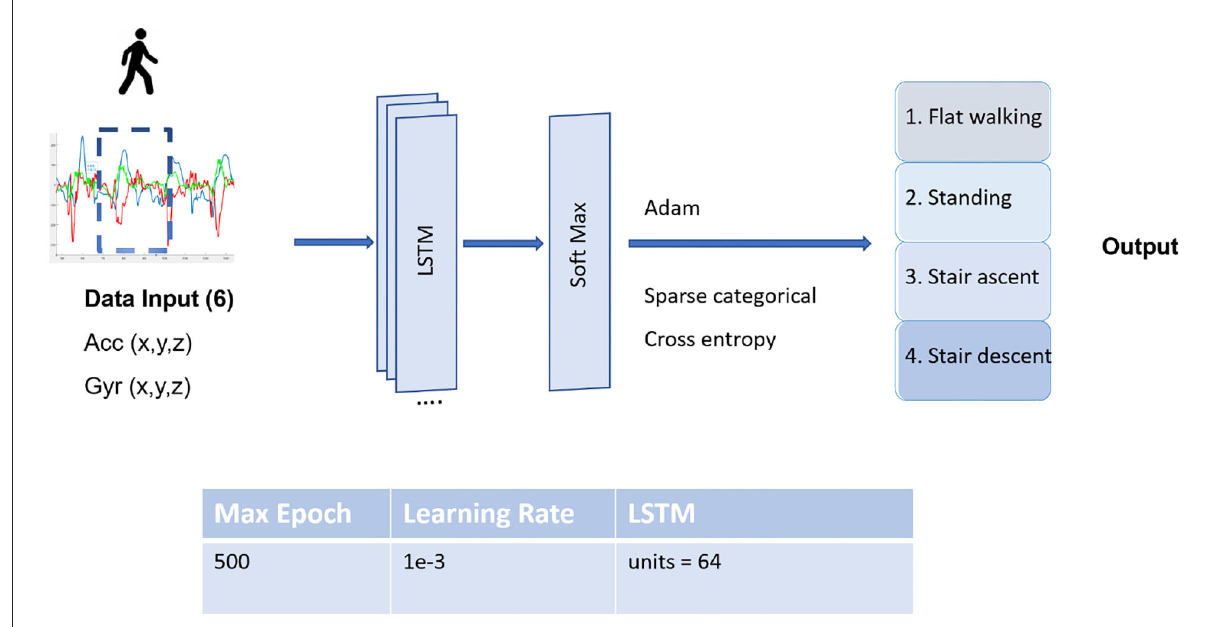
FIGURE5 The structure of the long short-term memory (LSTM) network and its parameters. The LSTM unit is implemented as a typical LSTM cell detailed by Colah (2015).